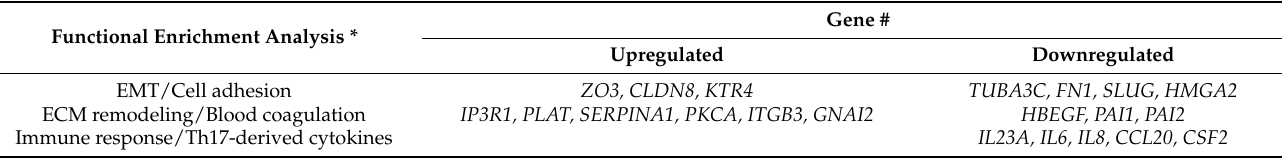
Table 1. Biological processes related to differentially expressed genes following TWIST knockdown.